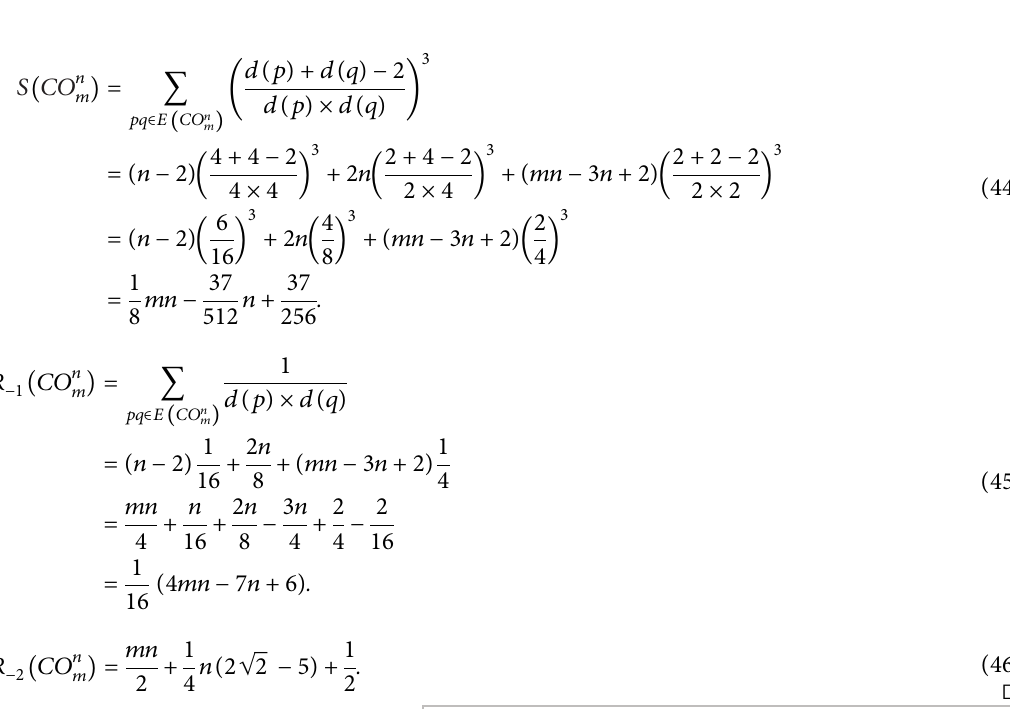
Figure 4: Example of the orthocactus chain graph of cycles for m � 3 and n � n